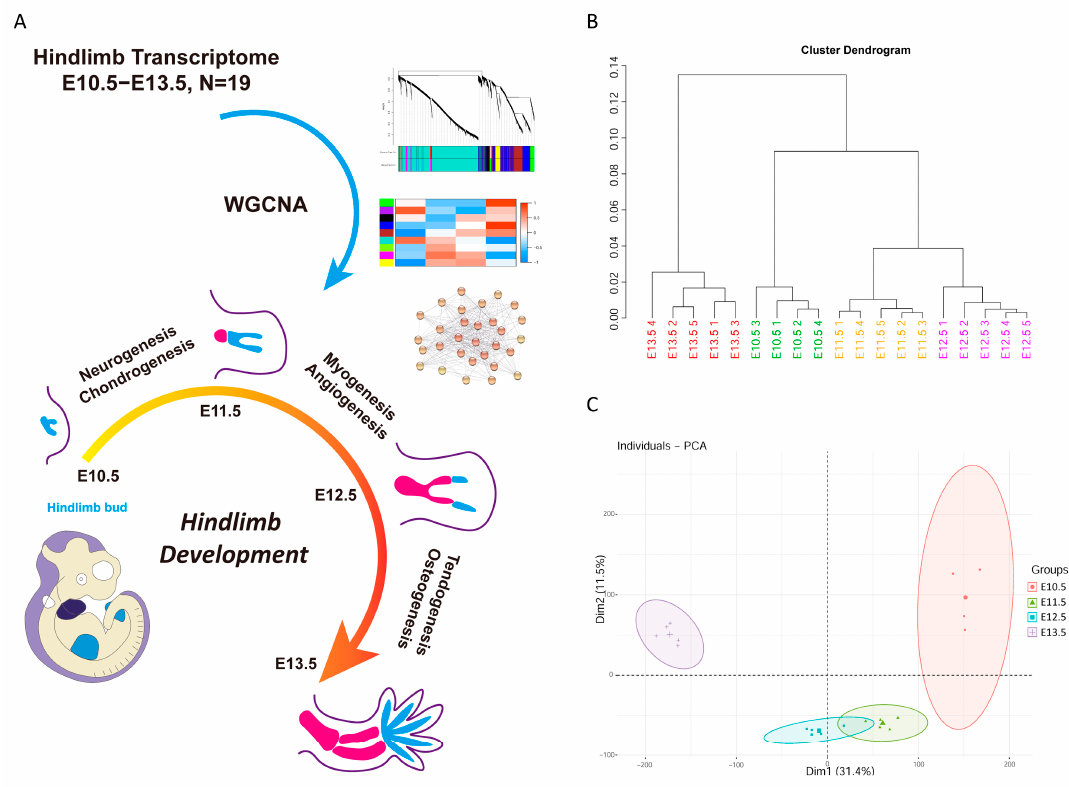
Figure 1. Study design and quality control of embryonic mice hindlimb transcriptome. ( A ) Workflow of hindlimb transcriptome and WGCNA analysis. Nineteen hindlimb transcriptome including four developmental stages from E10.5 to E13.5 were analyzed by WGCNA. Stage-associated modules were revealed and further transcription factor networks were constructed. ( B ) Cluster dendrogram of 19 hindlimb transcriptomes showed similarity of respective stage transcriptome. Light green, E10.5; yellow, E11.5; purple, E12.5; red, E13.5. ( C ) Principal component analysis of hindlimb transcriptome with four stages confirmed that different stages clustered separately. Circle, E10.5; triangle, E11.5; square, E12.5; cruciform, E13.5.